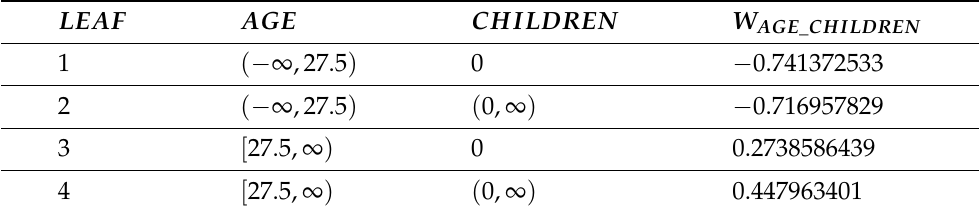
Table 4. Values obtained for W AGE _ CHILDREN from the tree depicted in Figure 5.